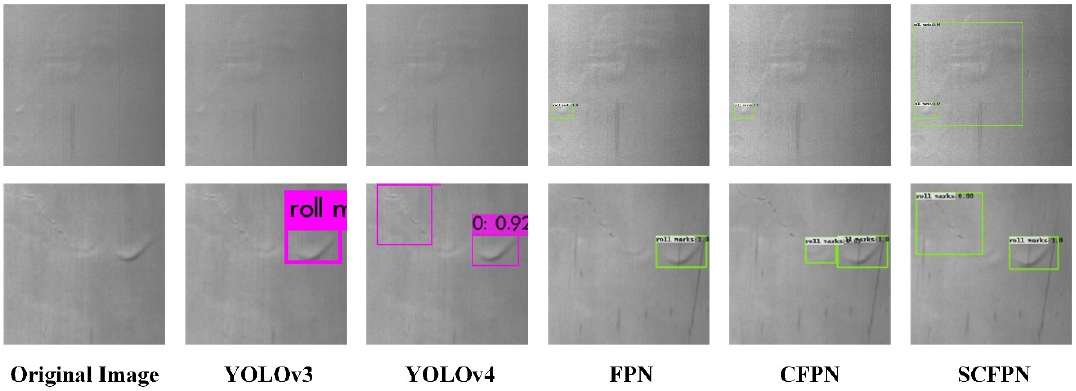
Figure 8. Visual detection results of different detection networks on CSU_STEEL. ( a ): tiny round roll marks; ( b ): long and narrow roll marks; ( c ) irregular roll marks with discontinuous shape; ( d ): concave roll marks with tiny line shape; (e): blurry and inclined roll marks